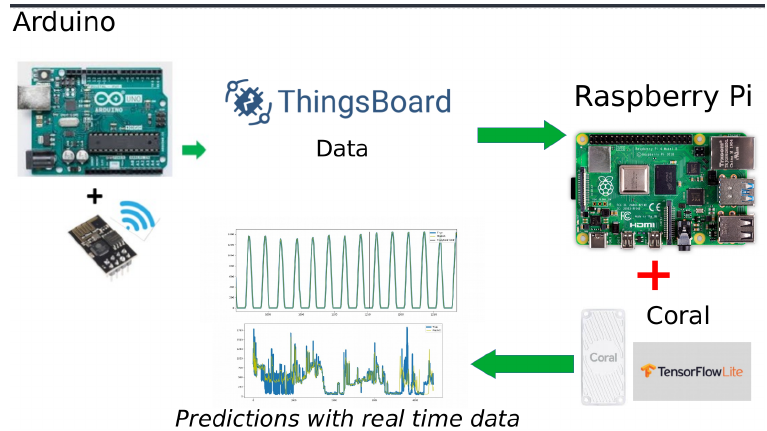
Figure 14. Prediction system with Raspberry Pi and Coral TPU